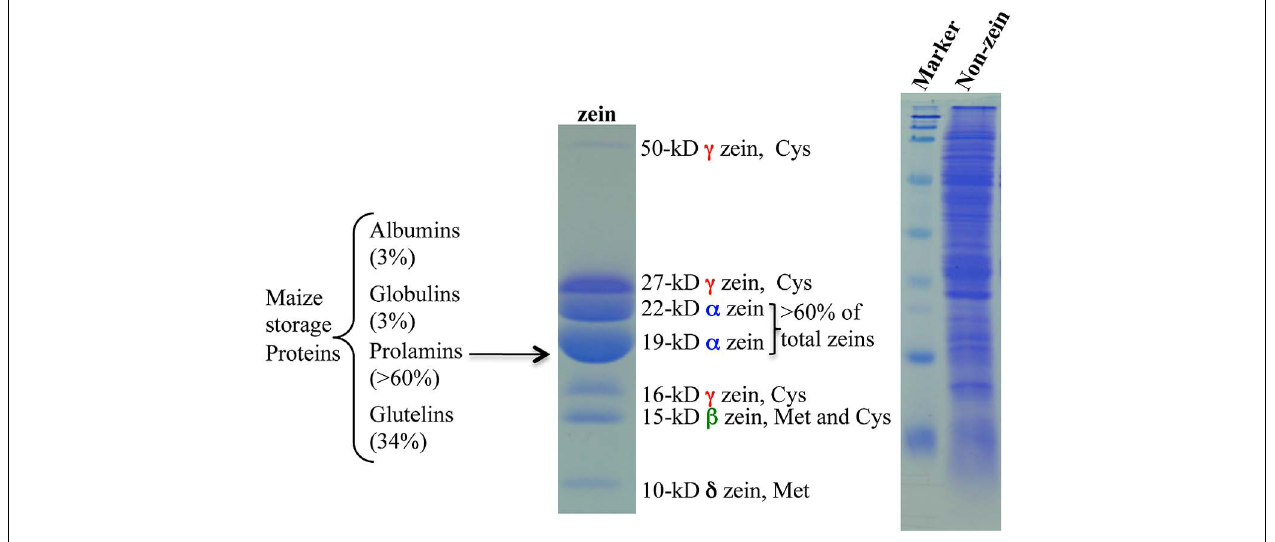
FIGURE 1 | Maize storage proteins. Prolamin proteins in maize are called zeins and the others are all classified as non-zeins. Adapted fromWu etal.